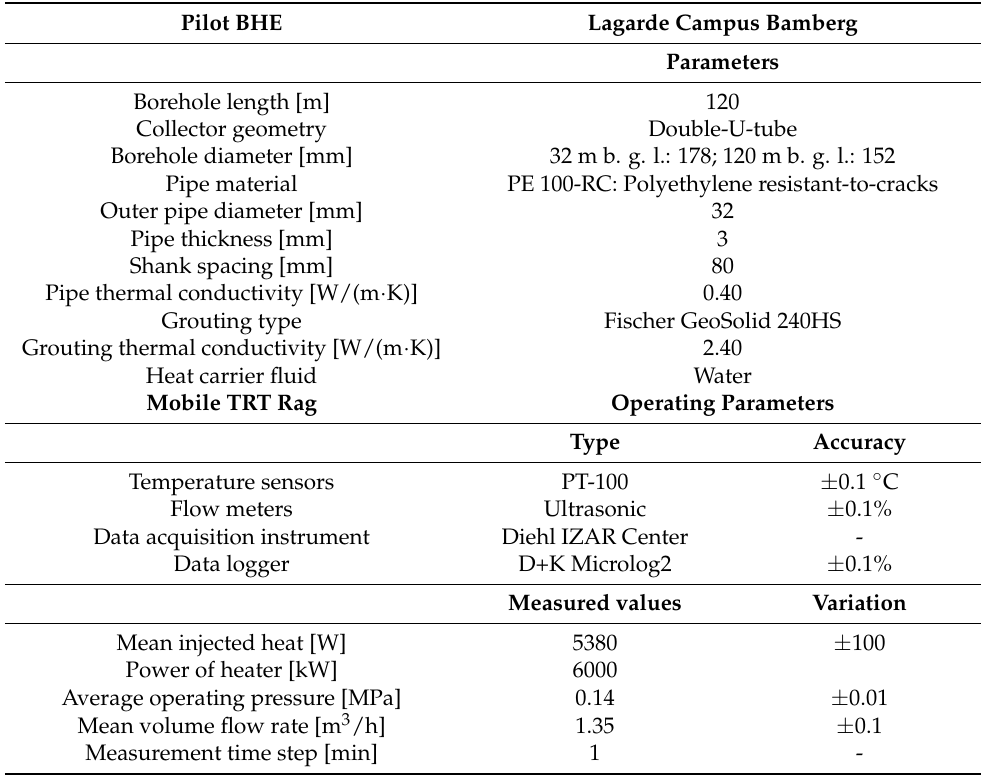
Table 1. Characteristics of the double-U borehole heat exchanger (BHE) and the mobile TRT device; depth in meters below ground level (b. g.